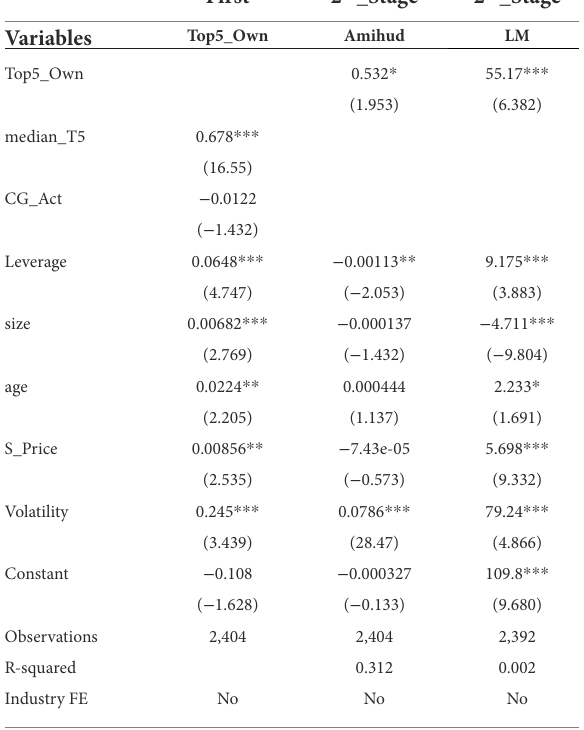
TABLE 9 Ownership concentration and stock liquidity (2SLS